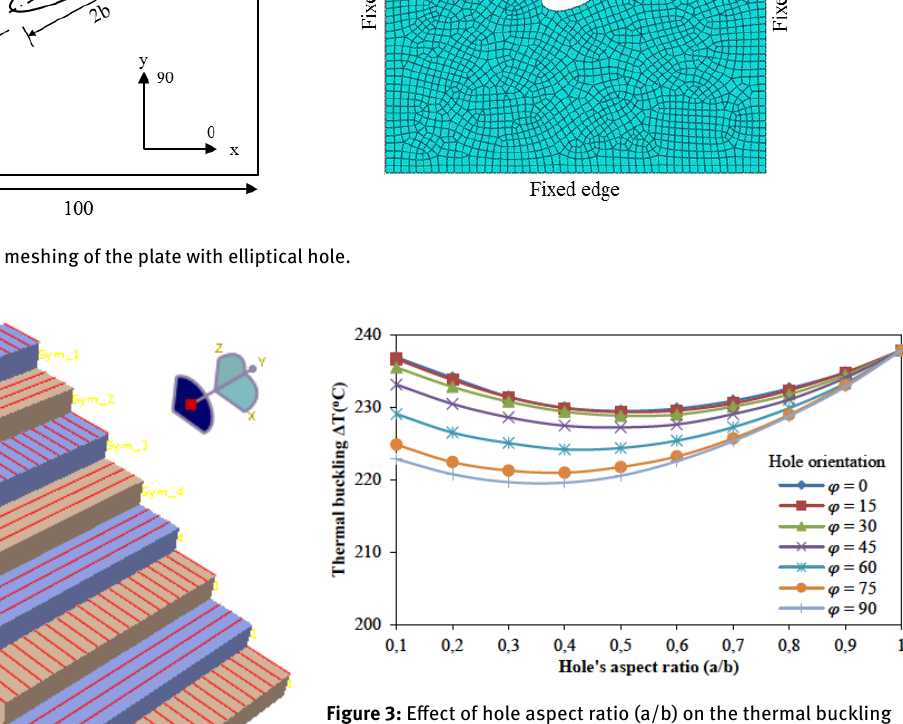
Figure 3: Effect of hole aspect ratio (a/b) on the thermal buckling